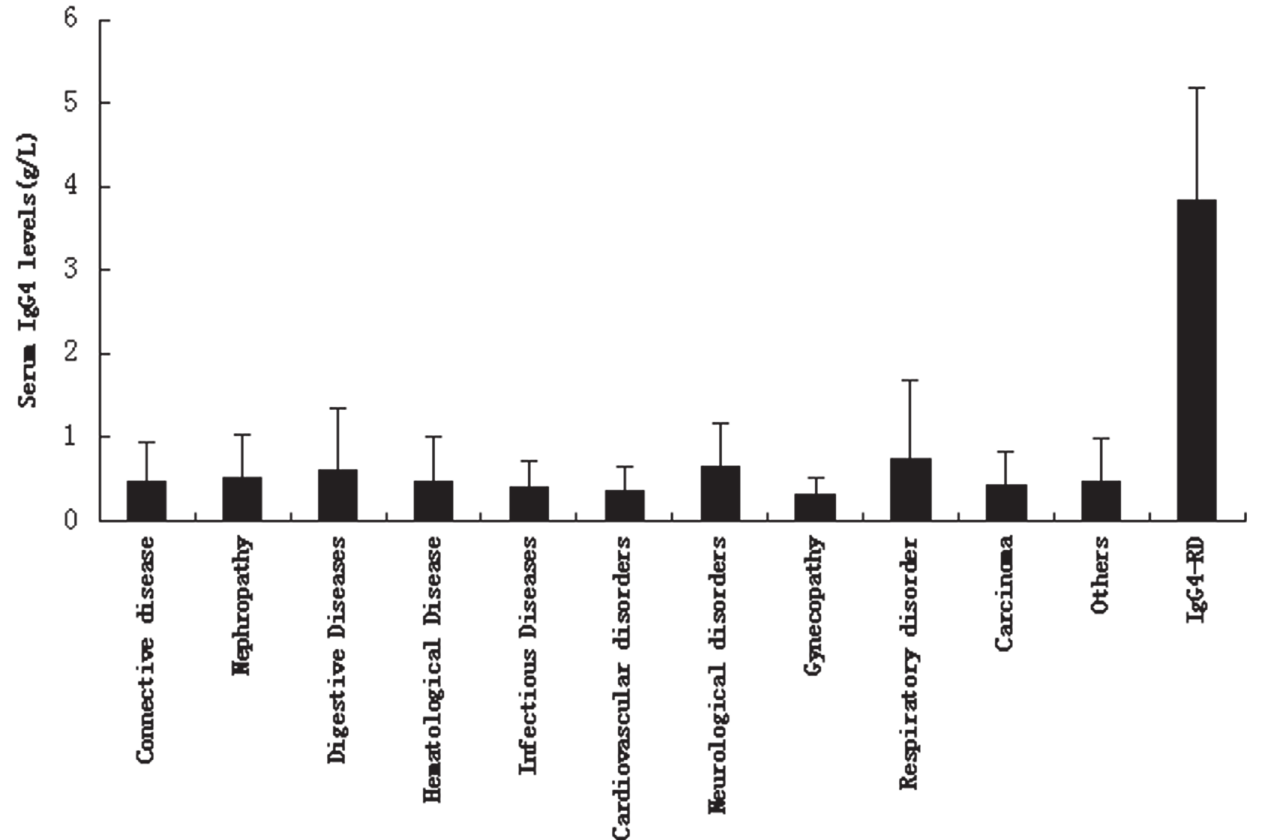
Fig 2. Serum IgG4 levels in various disorders (measured by ELISA). (mean ± SD = 0.46 ± 0.49g/L vs. 0.51 ± 0.52g/L vs. 0.61 ± 0.73g/L vs. 0.47 ± 0.53g/L vs. 0.41 ± 0.30g/L vs. 0.36 ± 0.30g/L vs. 0.65 ± 0.52g/L vs. 0.30 ± 0.20g/L vs. 0.73 ± 0.94g/L vs. 0.42 ± 0.41g/L vs. 0.48 ± 0.50g/L vs. 3.83 ± 1.36g/L)